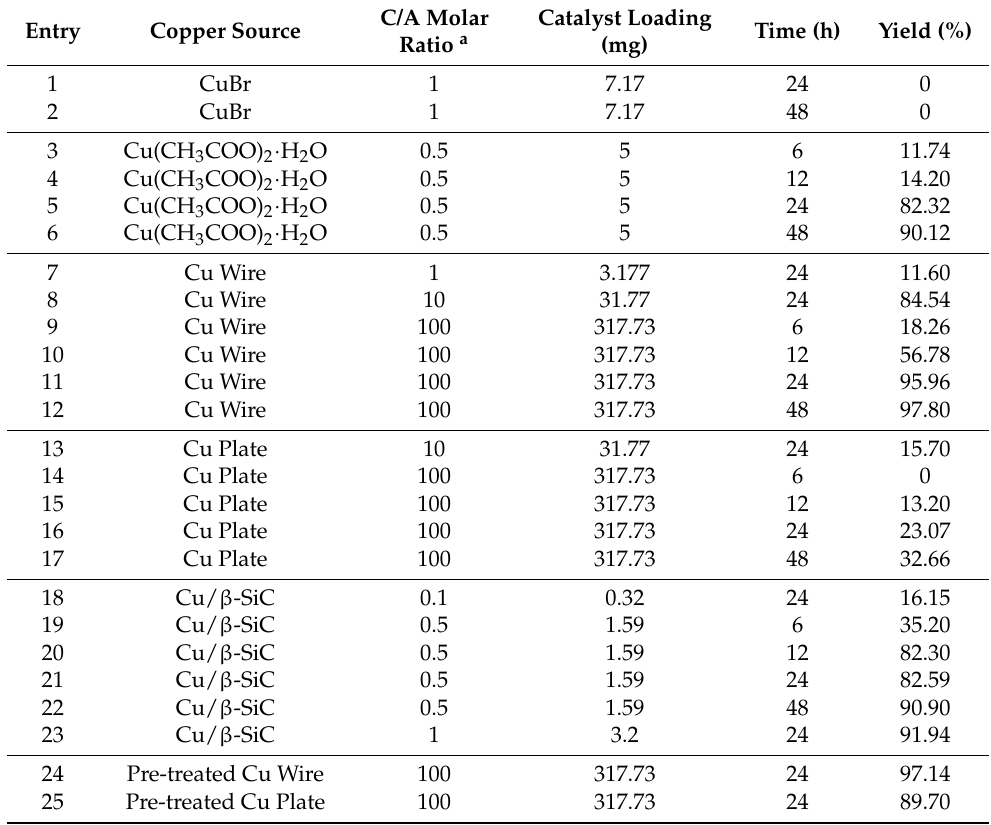
Table 2. Yield of CuAAC reaction with different catalysts in supercritical